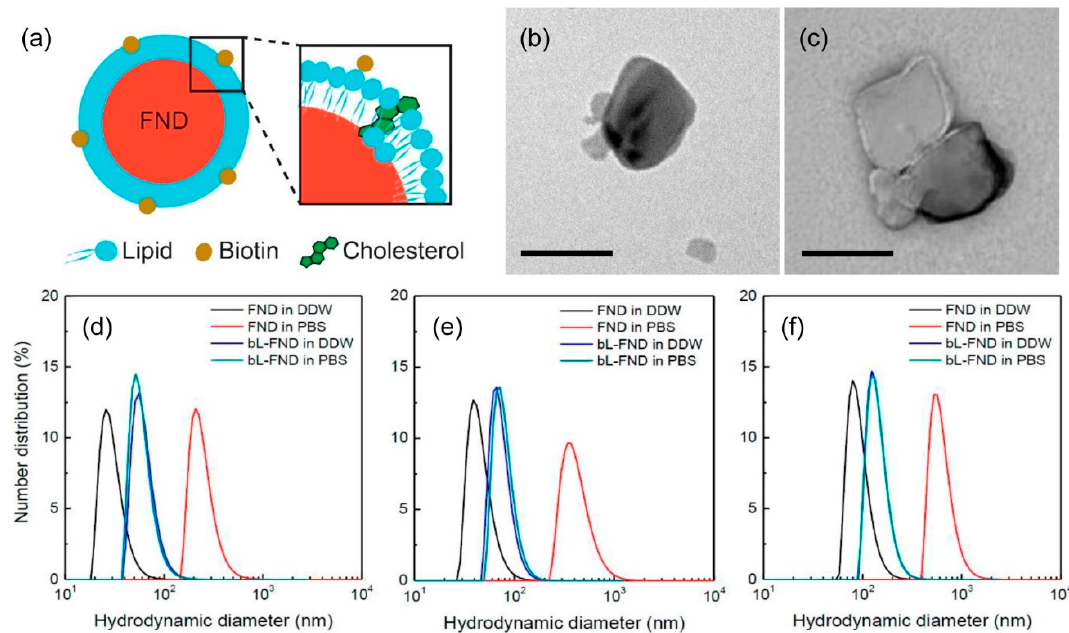
Figure 1. ( a ) Proposed structure of a biotinylated lipid-encapsulated (FND) (bL-FND). The structure is applicable for particles of different sizes, from 35 to 100 nm. ( b , c ) Transmission electron microscopy (TEM) images of bare FNDs (b) and bL-FNDs (c). Scale bars: 50 nm. ( d – f ) Number-averaged size distributions of FNDs with nominal diameters of 35 nm (d), 50 nm (e), and 100 nm (f) before and after coating with lipids in deionized distilled water (DDW) or phosphate-buffered saline (PBS), measured by dynamic light scattering (DLS).